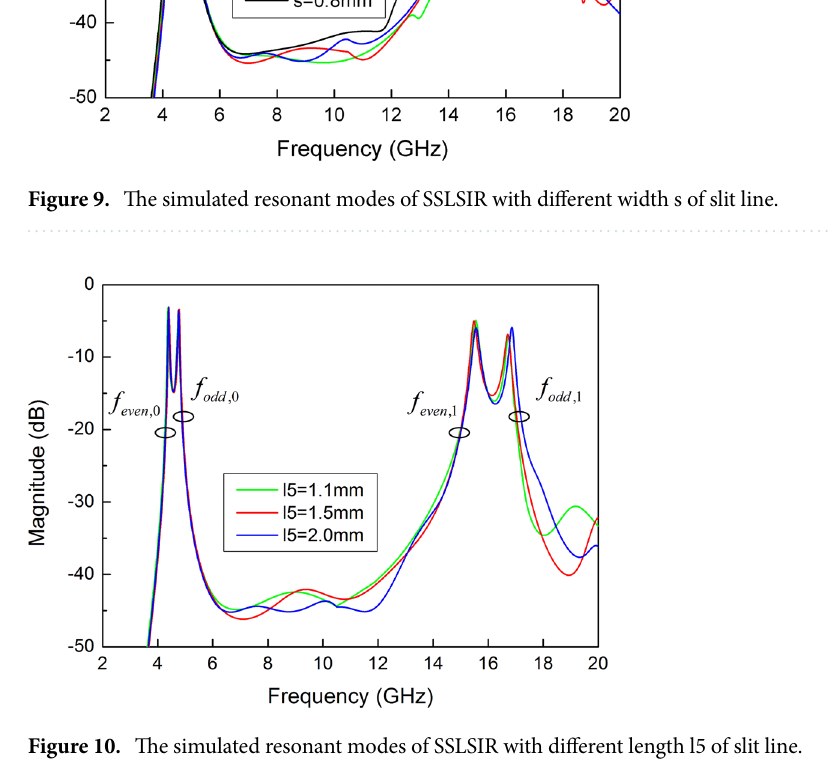
Figure 10. The simulated resonant modes of SSLSIR with different length l5 of slit